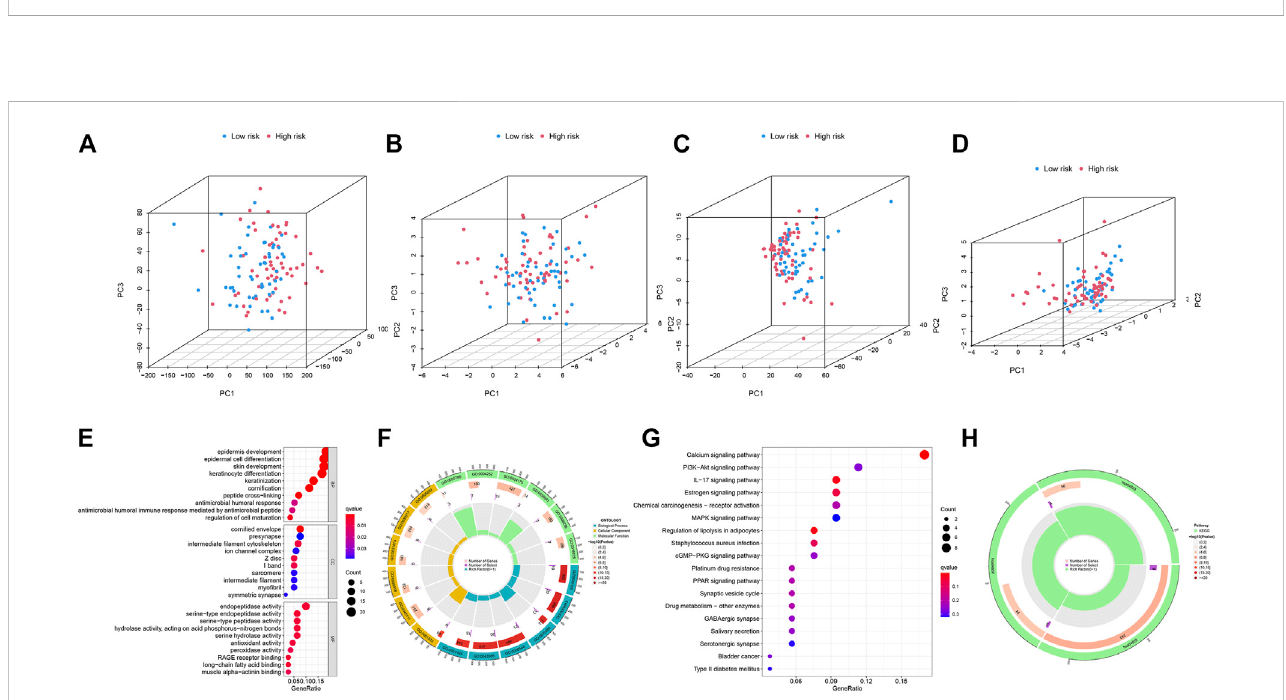
FIGURE 7 (A – D) PCA analysis of patients in low- and high-risk groups based on four expression pro fi les. (A) is from the entire gene expression pro fi les; (B) is from cuproptosis genes; (C) is from cuproptosis-related lncRNAs and (D) is from the 5 CRLs that established the risk model. (E – F) GO enrichment analysis of DEGs between the low- and high-risk groups in TCGA-HNSC. (G – H) KEGG enrichment analysis of DEGs between the low- and high-risk groups in